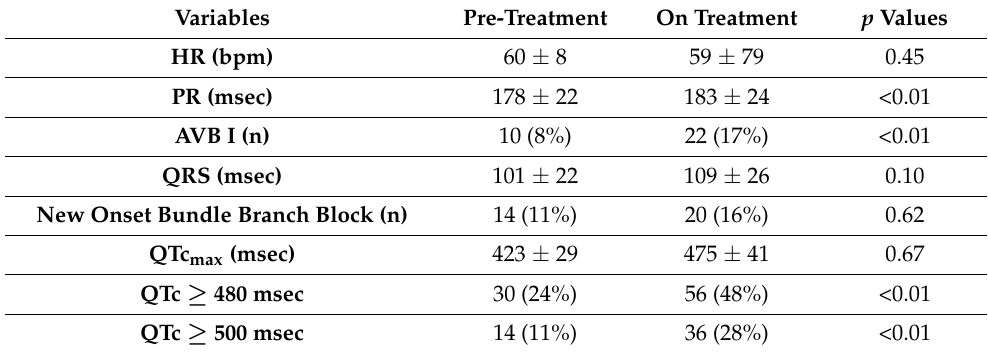
Table 2. Electrocardiographic changes on disopyramide treatment.